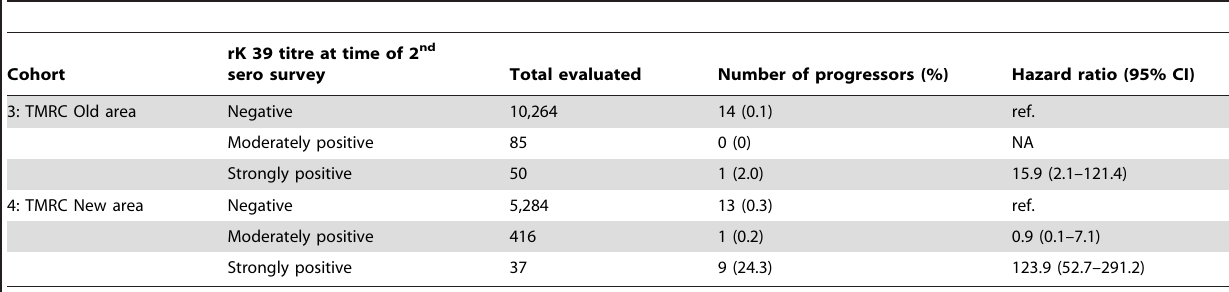
Table 5. Risk of progression to symptomatic VL in individuals who seroconverted compared to individuals who did not seroconvert, calculated by groups with low, moderate or high rK39 titers at the time of seroconversion.